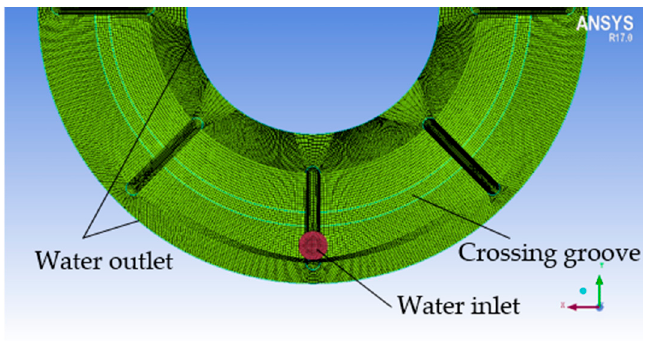
Figure 7. Mesh model of the water film.